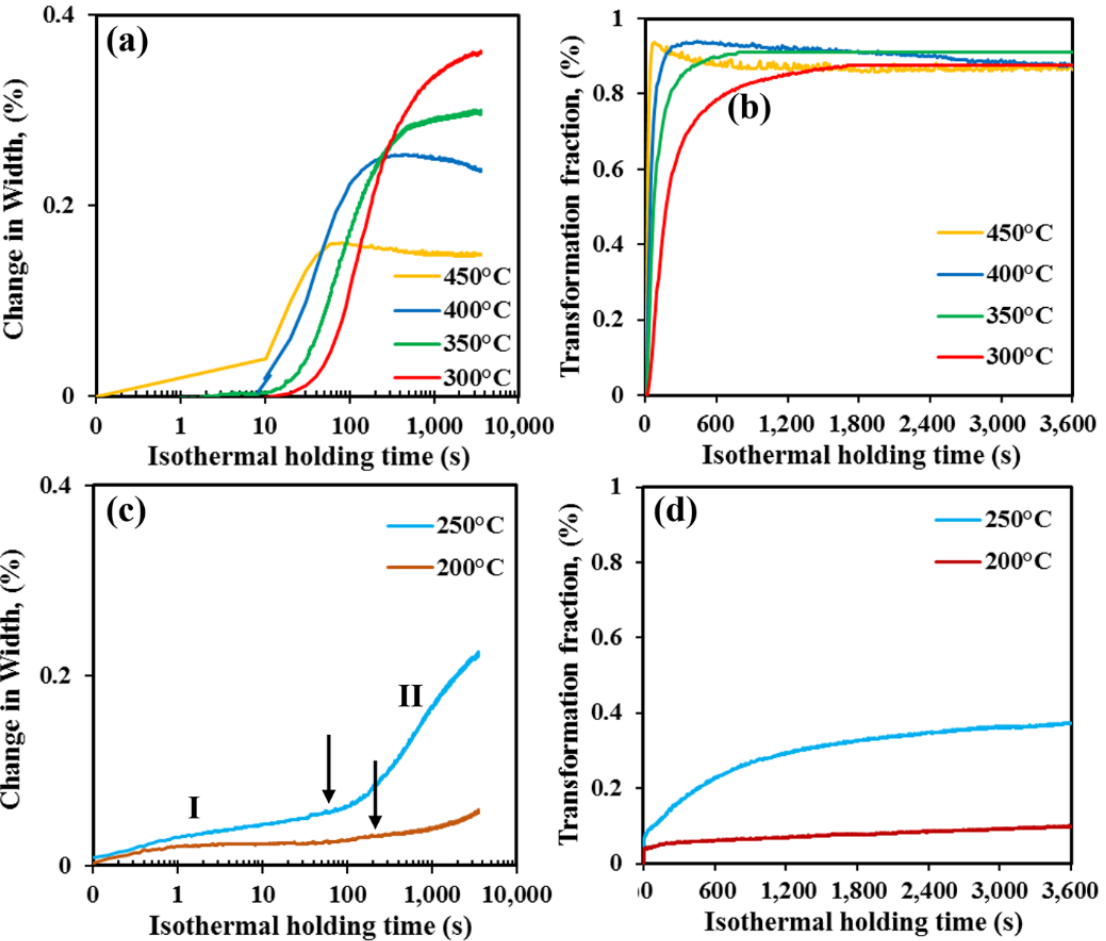
Figure 3. Dilatation curves showing changes in specimen width with time corresponding to isother- mal holding for 1 h at different temperatures: ( a , b ) Q&B and ( c , d ) Q&P treatments shown in both logarithmic ( a , c ) and linear ( b , d ) scales.